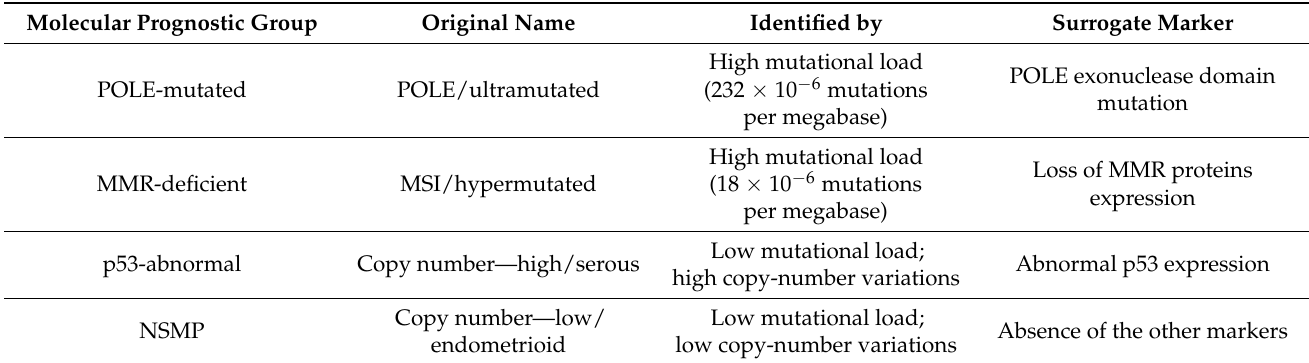
Table 1. Definition of the 4 molecular prognostic groups of endometrial carcinoma.